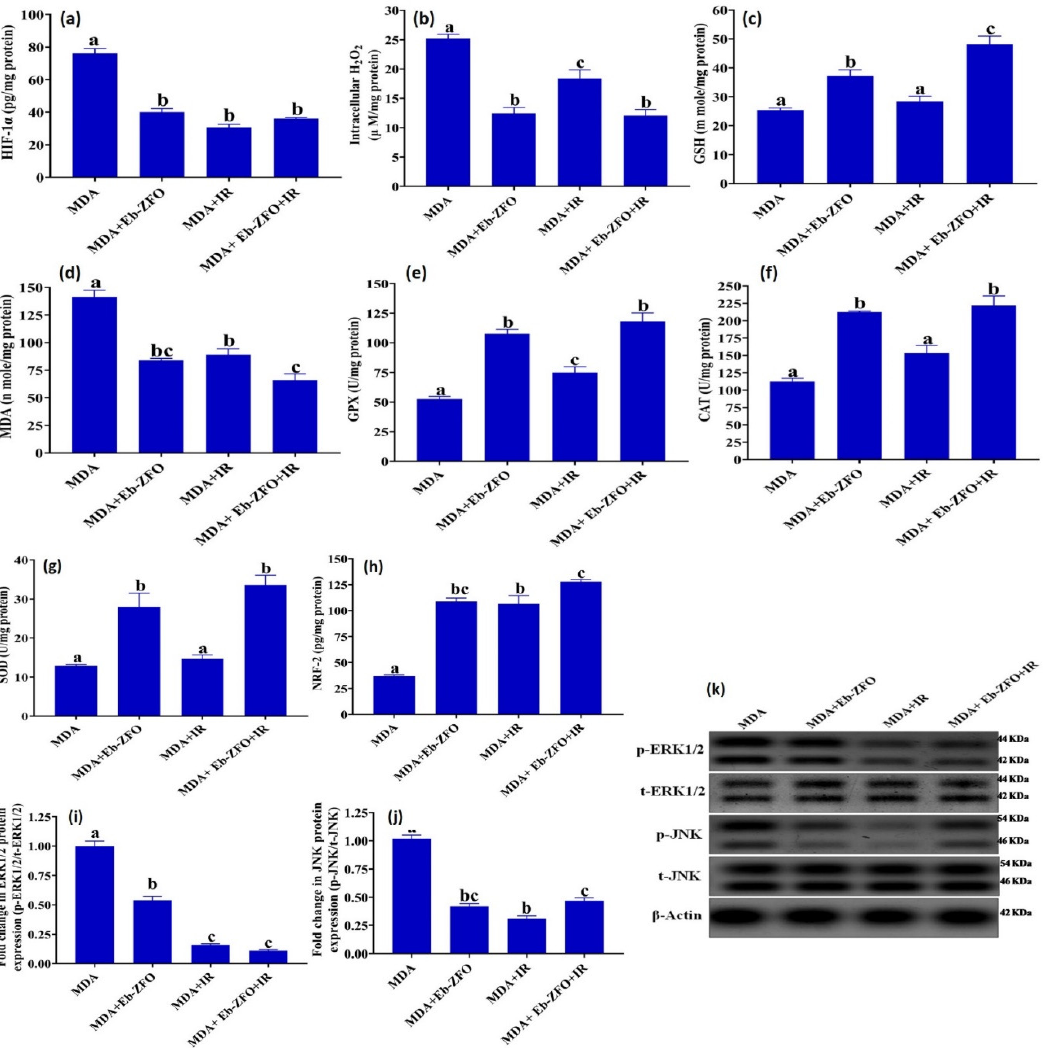
Figure 13. ROS status and associated signalling molecules ERK1/2, JNK, and NRF-2 in the MDA-MB-231 cell line. ROS status indicators were the levels of ( a ) HIF-1 α , ( b ) intracellular H 2 O 2 , ( c ) GSH, and ( d ) MDA; activities of ( e ) GPX, ( f ) CAT, and ( g ) SOD. ROS-sensing signalling molecules were ( h ) NRF-2 level; fold change in protein expression of ( i ) ERK1/2, ( j ) JNK, and ( k ) representative western blot analysis, SDS-PAGE of ERK1/2, JNK, and β - actin. Results are expressed as the mean and standard error of the mean (SEM) (n = 3). Columns with dissimilar letters (a, b, c . . . ) overhead within the same histogram are significantly different, and columns that have the same letters are not significantly different at p < 0.05. MDA group: untreated MDA-MB-231 cells served as control, MDA + Eb-ZFO group: MDA-MB-231 cells treated with Ebselen (Eb) and ZnFe 2 O 4 nanoparticles (ZFO), MDA + IR group: MDA-MB-231 cells exposed to γ -radiation; and MDA + Eb-ZFO + IR group: MDA-MB-231 cells treated with Eb-ZFO and exposed to